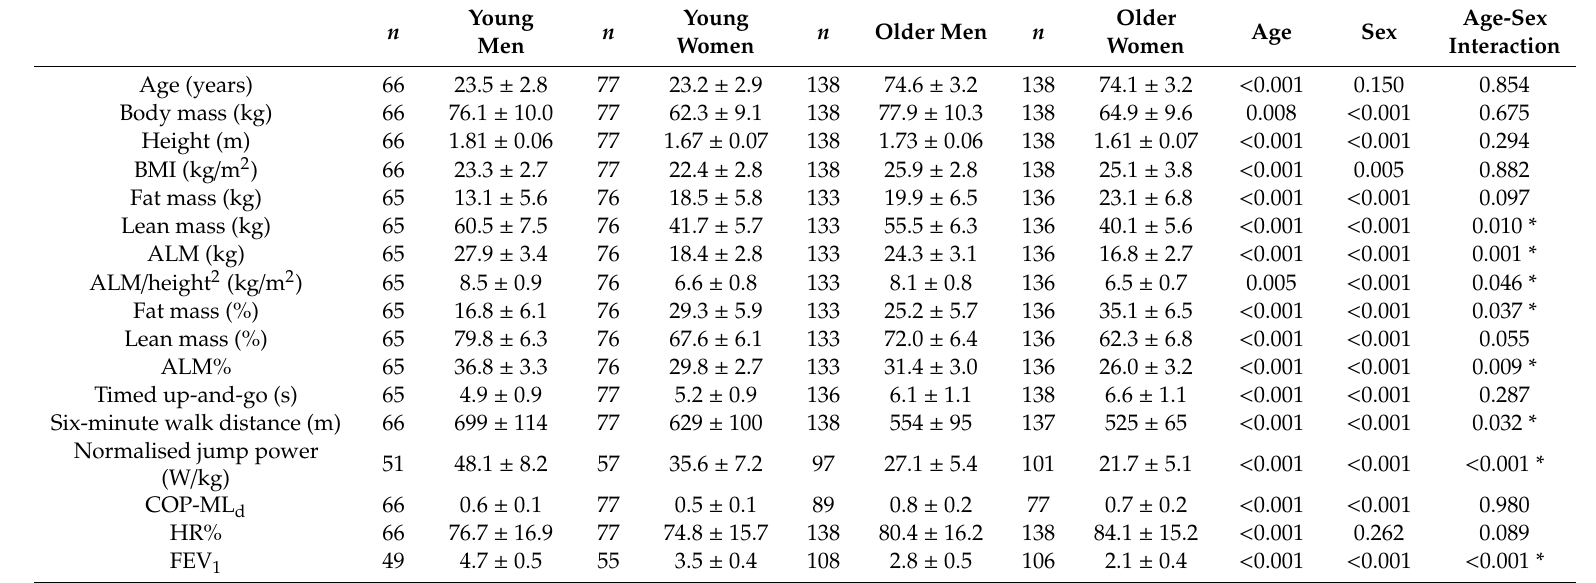
Table 1. Characteristics of study